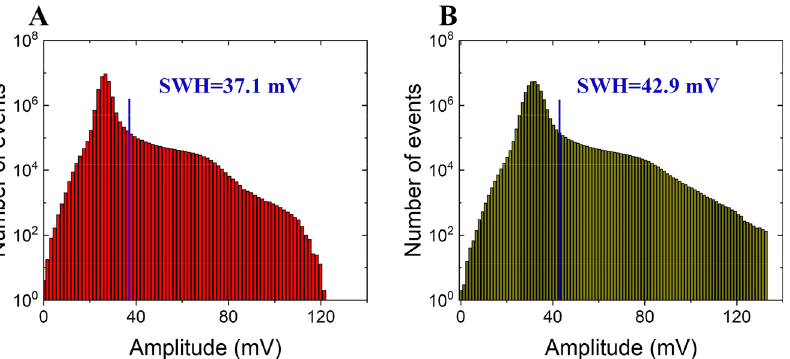
Figure 7: Intensity histograms of chaotic multiple-pulse bunch at (A) 500mW and(B) 600 mW.